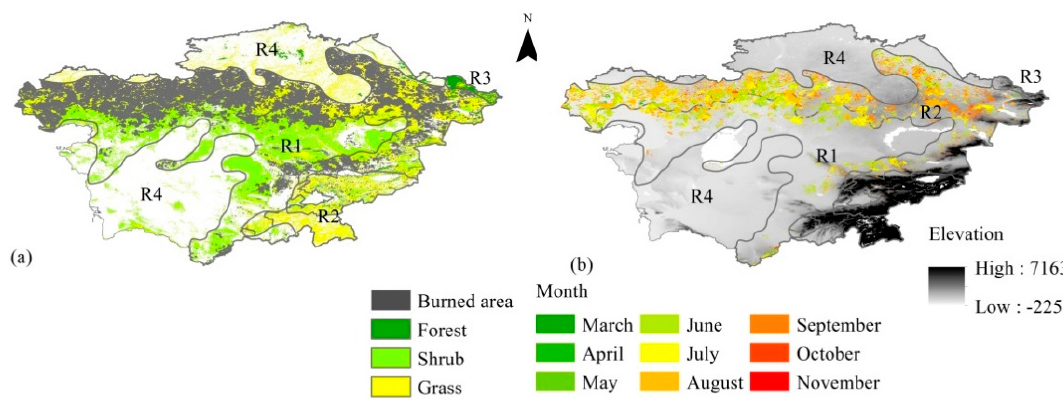
Figure 6. Burned area distribution in the study area during the 2001–2015 period.